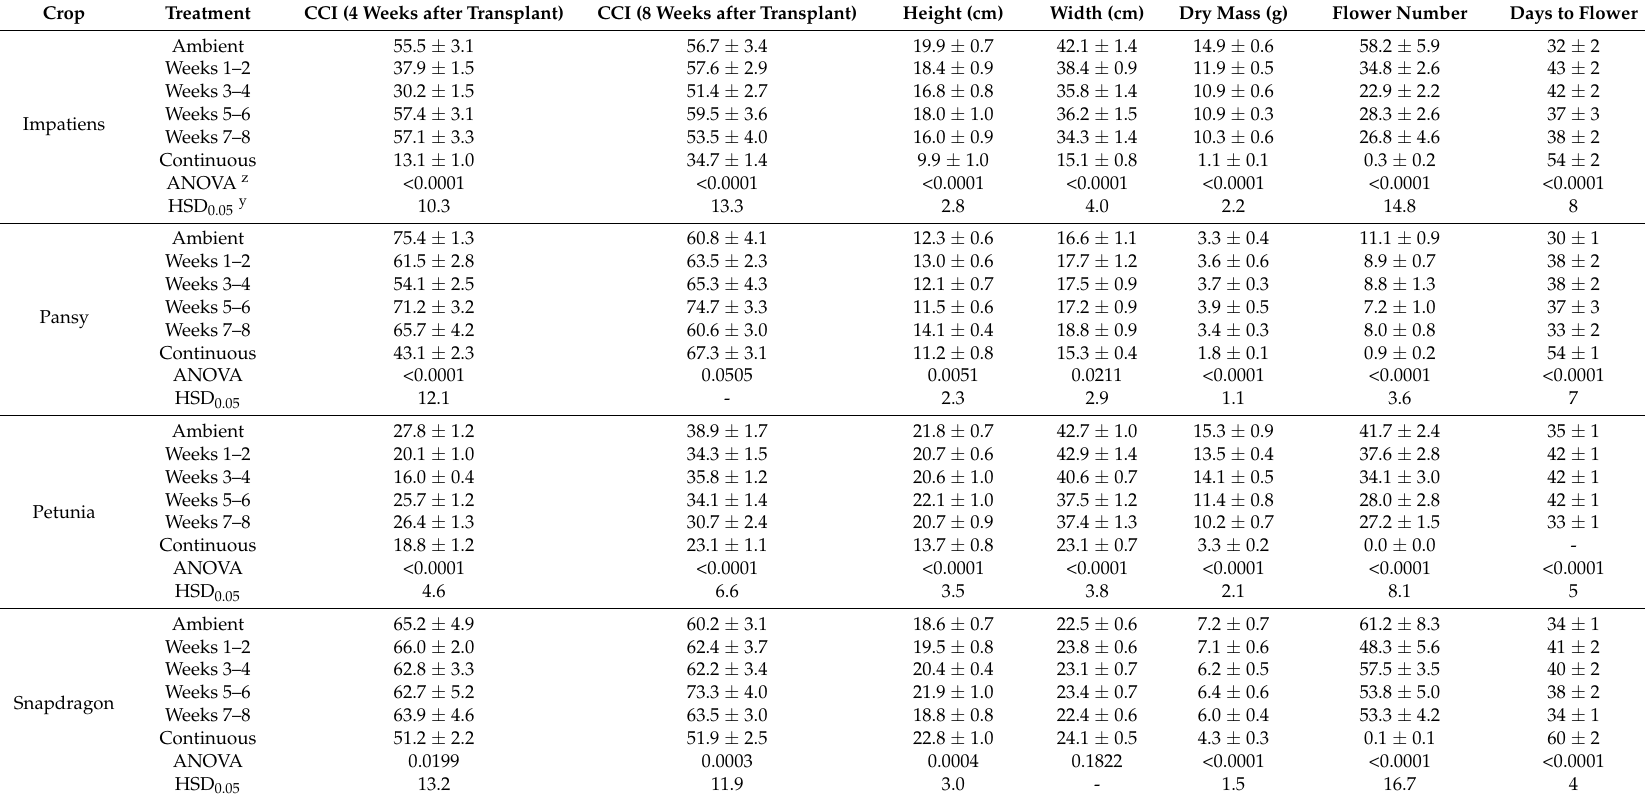
Table 2. Plant growth and flowering of impatiens ( Impatiens walleriana ‘Accent Orange’), pansy ( Viola × wittrockiana ‘Delta Premium Blue Blotch’), petunia ( Petunia × hybrida ‘Dreams Pink’), and snapdragon ( Antirrhinum majus ‘Montego Violet’) grown in ambient conditions (ambient), grown in ambient conditions and transferred to a low-energy environment at two-week intervals during an eight-week production cycle, or grown continuously in the low-energy environment (continuous). Ambient conditions were 22/18 ◦ C air temperature, 14 h photoperiod, and ambient irradiance + 75 µ mol · m − 2 · s − 1 supplemental lighting from high-pressure sodium (HPS) lamps when photosynthetic photon flux density (PPFD) was less than 300 µ mol · m − 2 · s − 1 . Low-energy conditions were 13/10 ◦ C air temperature,